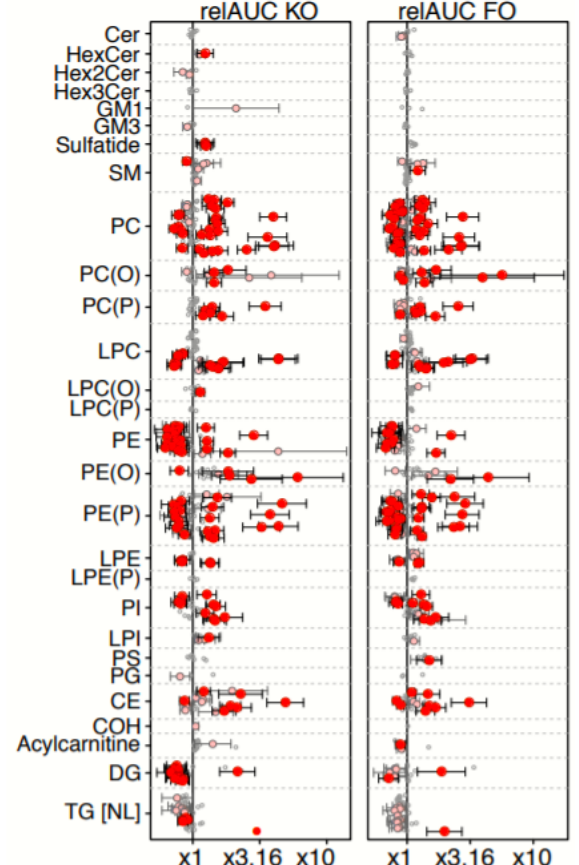
Figure 4. Relative AUCs of molecular lipid species following KO and FO supplementation for 30 days. Points show the mean relative area under the curve (relAUCs) for all molecular lipid species following KO (left) and FO (right) supplementation for 30 days. relAUC is an estimate of the total plasma lipid flux over the 30-day period. Values on the x-axis are expressed as (log-scaled) folds: a value of x1 indicates a constant lipid level over the course of the treatment, values above x1 indicate an overall gain, values below x1 indicate an overall loss. Dot colors: red = significant after multiple testing correction (adjusted p < 0.05, with 95% confidence intervals); pink = nominally significant (unadjusted p < 0.05, with 95% confidence intervals); grey = non-significant (no confidence intervals).